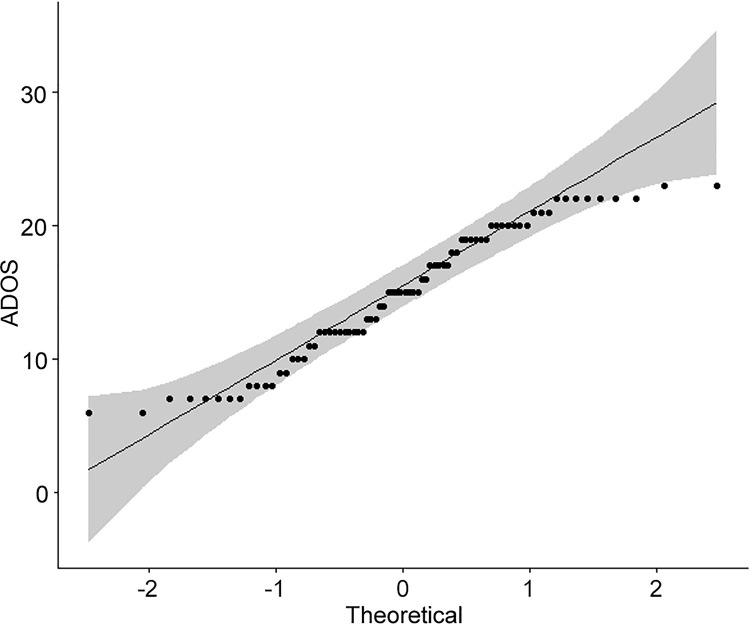
Range of ADOS scores among the ASD boys.Each dot represents the ADOS total score for a single subject.